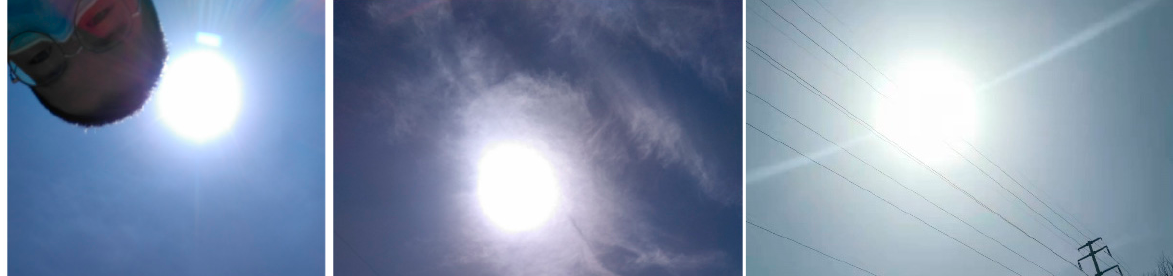
Figure 16. Typical interference factors in optical path measurement.